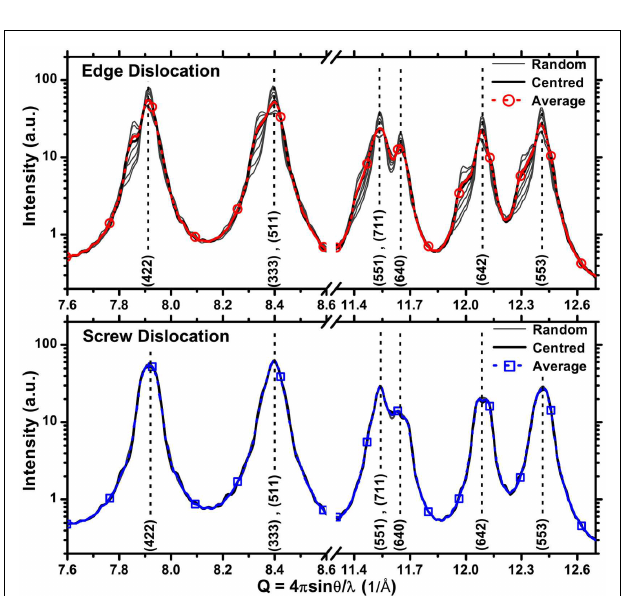
FIGURE 7 | X-ray powder diffraction pattern simulated by DSE from the (“equilibrated”)TAM of cylindrical Pd nanocrystals ( D = H = 16nm) with edge (upper plot) and screw (lower plot) dislocation lines parallel to the cylinder axis, crossing the circular basis in different positions (center, random, and average)